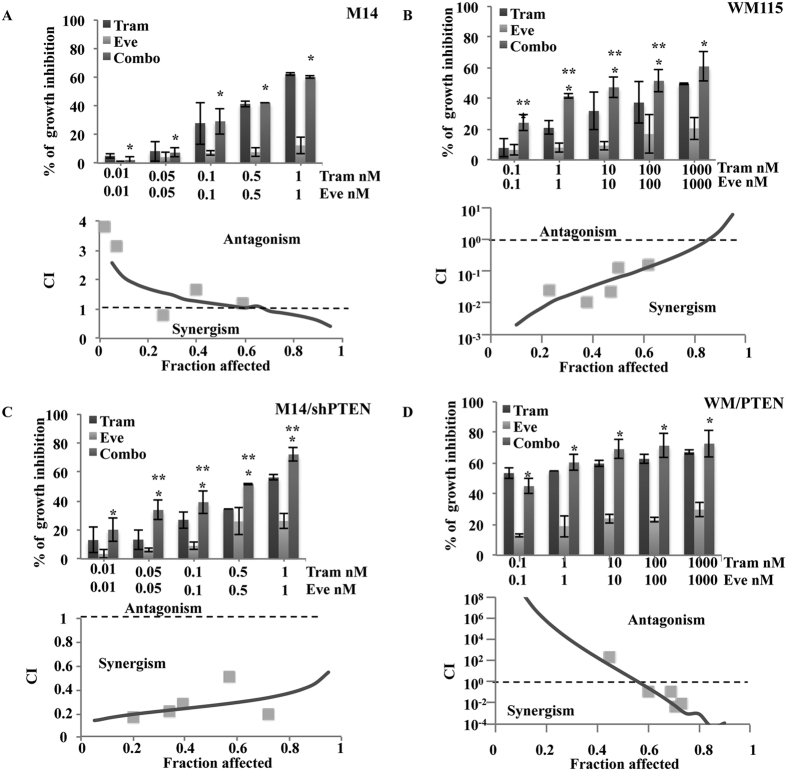
Genetic manipulation of PTEN expression modifies response to combined MEK/mTOR inhibition.(A–C) M14 clones stably transfected with either an empty plasmid vector (M14) or a plasmid encoding shPTEN (M14/shPTEN) were treated with Trametinib (Tram) and Everolimus (Eve), alone or in combination, using a fixed ratio (Combo 1:1). Cell viability was assessed by Crystal violet assay after 72 h. Results are expressed as percentage of growth inhibition relative to untreated control and represent the average ± SEM of three independent experiments (top). CI were calculated by conservative isobologram analysis for experimental data and plotted against the fraction affected (bottom). Asterisks indicate statistically significant differences (p < 0.05 by 2-tailed Student’s t test) for the comparison between *Everolimus- and combination-treated cells or **Trametinib- and combination-treated cells. (B–D) WM115 clones stably transfected with either an empty plasmid vector (WM115) or a plasmid encoding a GFP-tagged PTEN (WM/PTEN) were treated with Trametinib (Tram) and Everolimus (Eve), alone or in combination using a fixed ratio (Combo 1:1). Cell viability was assessed by Crystal violet assay after 72 h. Results are expressed as percentage of growth inhibition relative to untreated control and represent the average ± SEM of three independent experiments (top). CI were calculated by conservative isobologram analysis for experimental data and plotted against the fraction affected (bottom). Asterisks indicate statistically significant differences (p < 0.05 by 2-tailed Student’s t test) for the comparison between *Everolimus- and combination-treated cells or **Trametinib- and combination-treated cells.